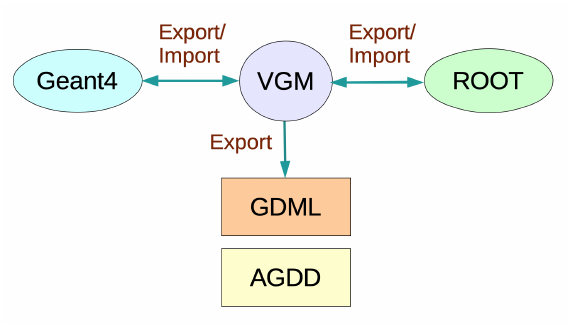
Figure 1. VGM functions